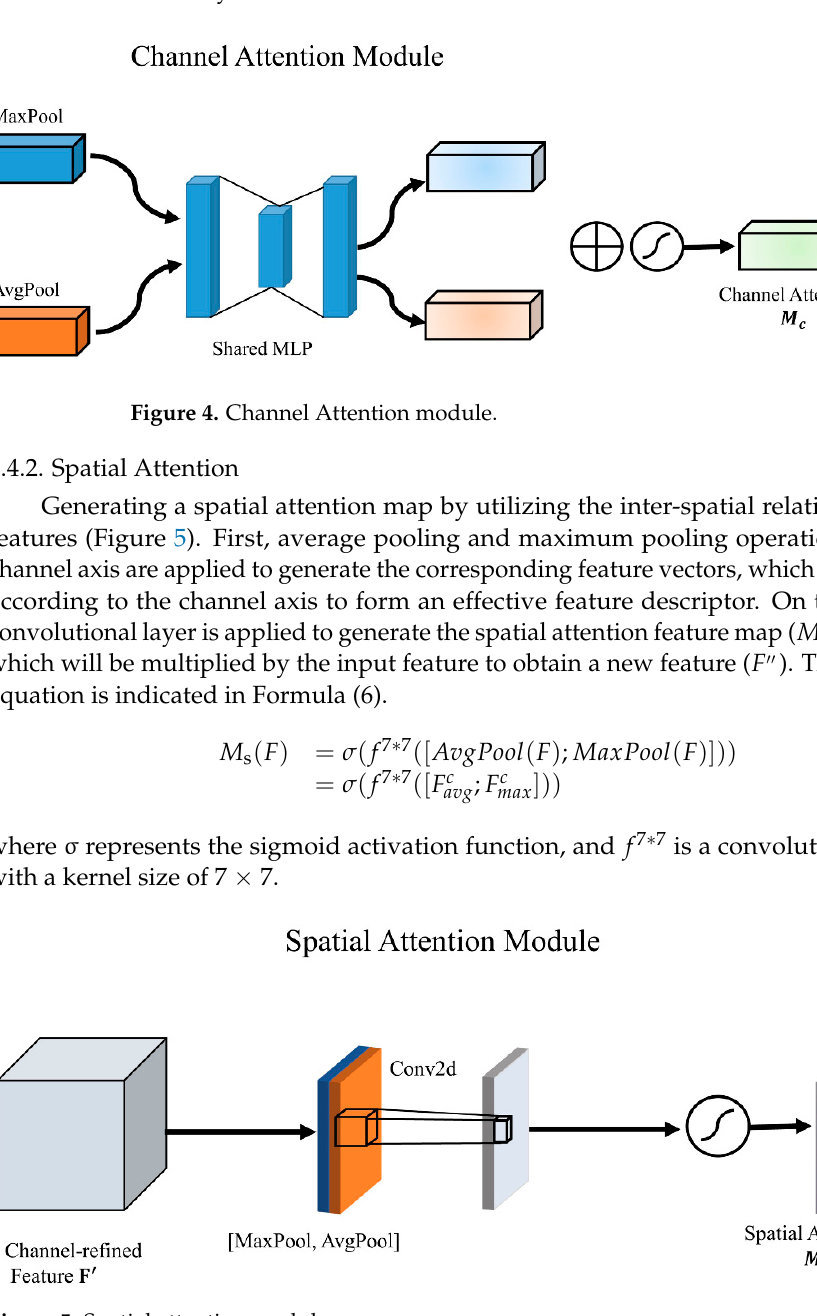
Figure 6. Convolutional block attention module prototypical networks (CBAM-P-Net) classification framework.